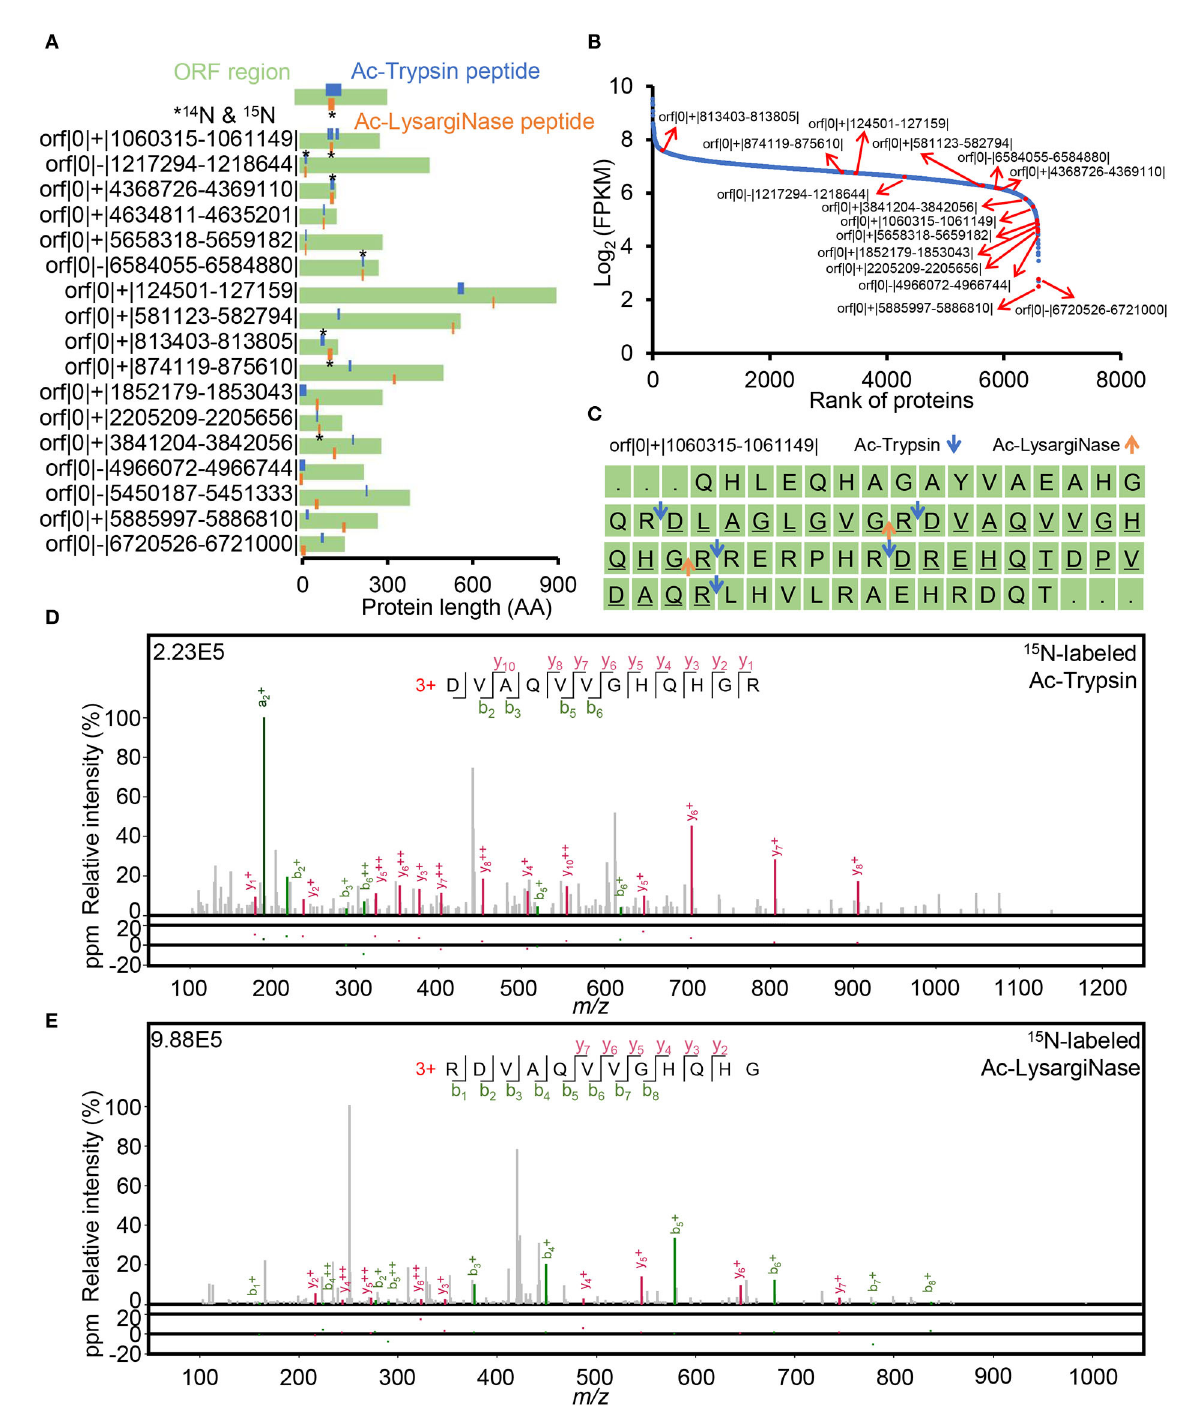
FIGURE5 Verification of 17 novel ORFs. (A) novel peptide distribution in non-coding regions. Peptide labeled star stands for 14 N and 15 N labeling spectra identification. (B) FPKM rank of annotated and novel ORFs based on a public RNA-seq dataset. (C) Distribution of novel peptides digested by Ac-Trypsin and Ac-LysargiNase in orf|0| + |1060315-1061149|. The underlined sequences were identified as peptides derived from Ac-Trypsin and Ac-LysargiNase digestion in this study. The blue and orange arrows indicate the Ac-Trypsin and Ac-LysargiNase cleavage sites, respectively. The credible spectra of two different peptides, (R)DVAQVVGHQHGR and RDVAQVVGHQHG(R), from the Ac-Trypsin (D) and Ac-LysargiNase (E)